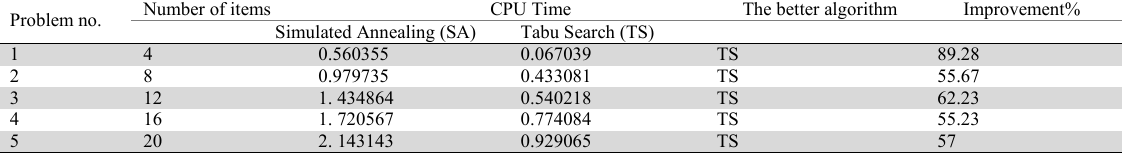
The required CPU time of the algorithms in crisp mode Problem no.